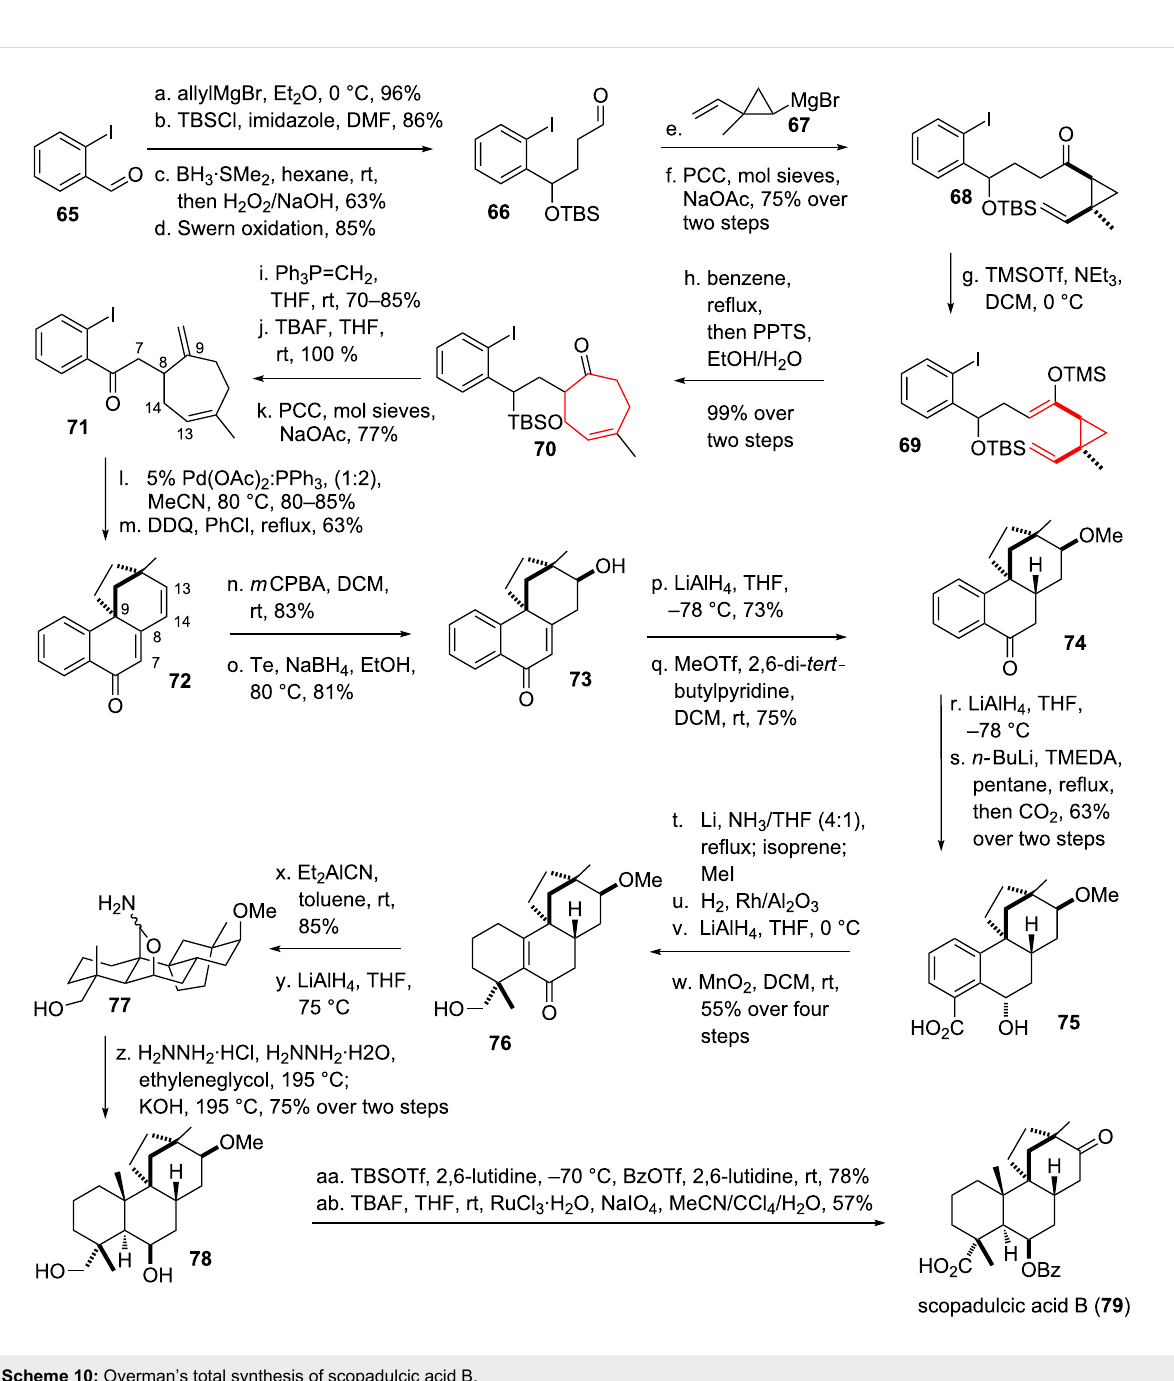
tion of the less hindered double bond yielded tricycle 96 , for which the yield and enantioselectivity was determined starting from 93 . Standard functional group interconversion